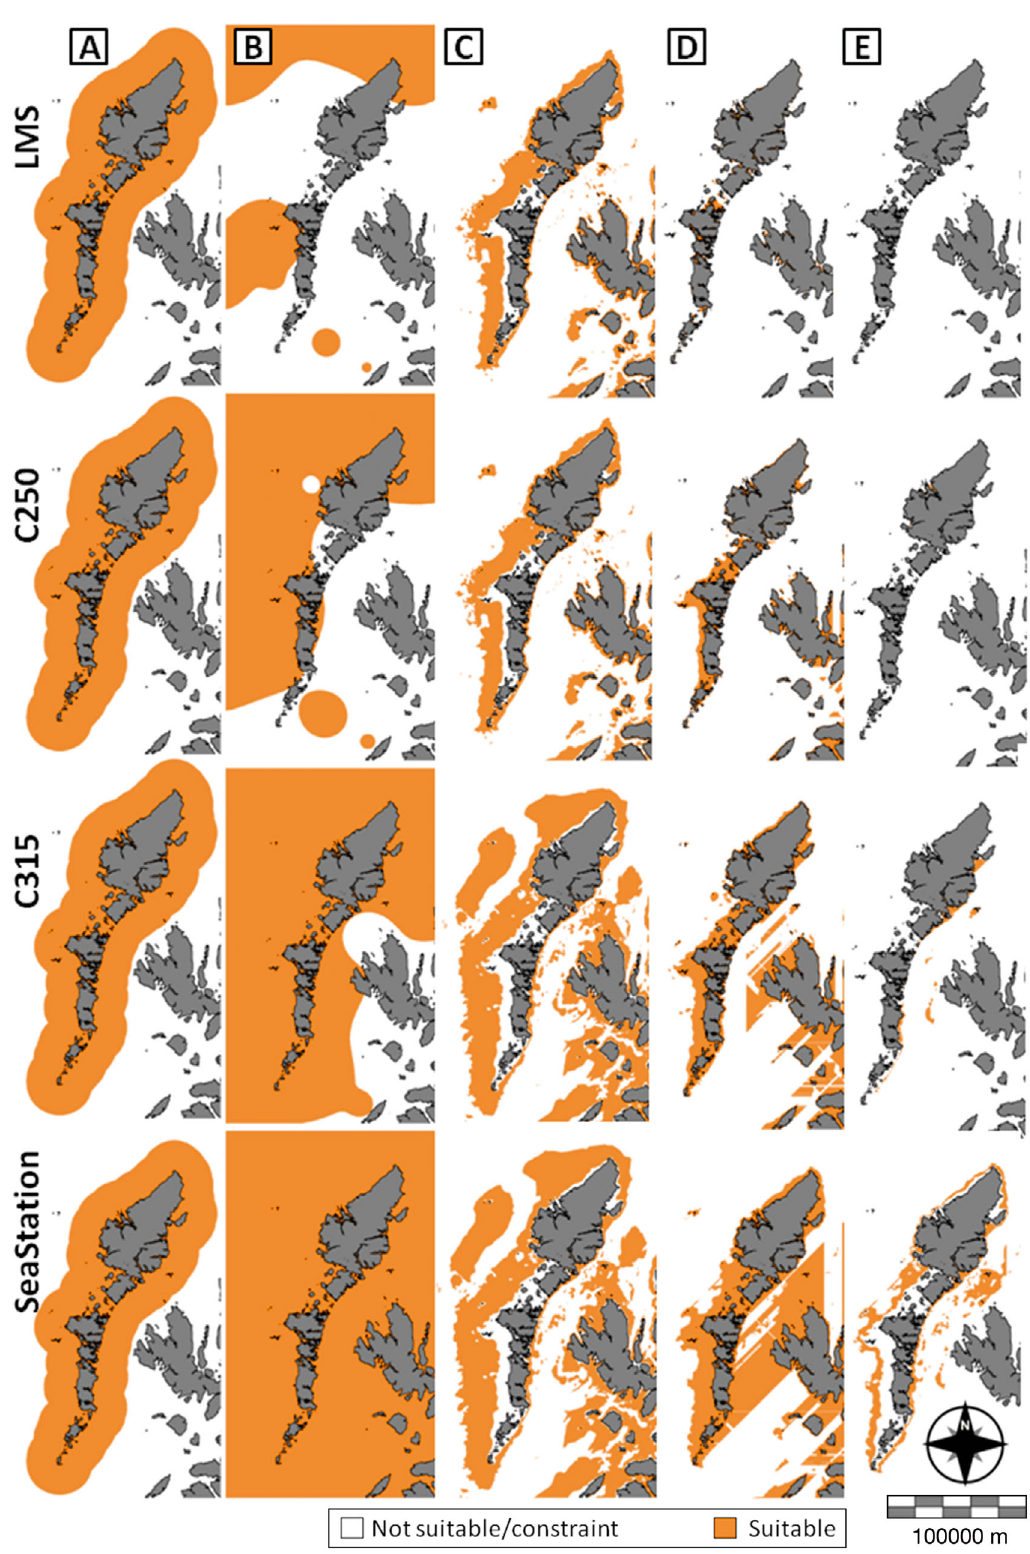
Fig. 3. Individual Boolean submodels and overall Boolean constraints layer. (A) Distance to coast, (B) maximum current velocity, (C) depth, (D) significant wave height, (E) overall constraints model. Cage types: LMS, C250, C315,